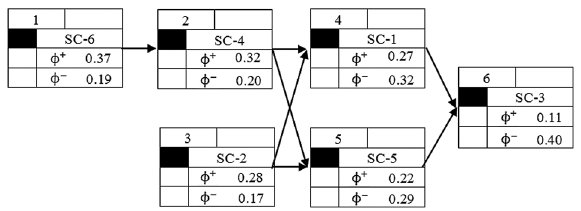
Fig. 1. PROMETHEE I partial ranking